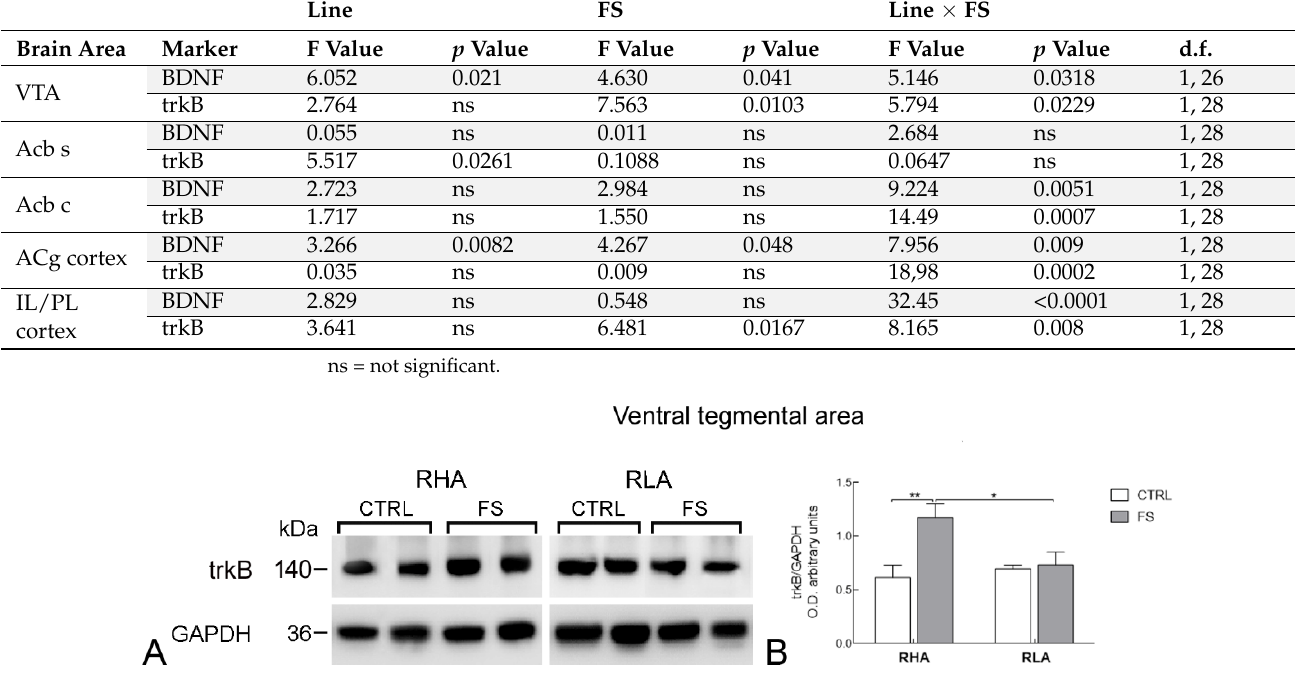
Figure 4. Western blot analysis of the trkB receptor protein levels in the ventral tegmental area of RHA and RLA rats under baseline conditions (CTRL) and after a 15 min session of forced swimming (FS): ( A ) shown are representative samples from two rats; and ( B ) densitometric analysis of the trkB/GAPDH band gray optical density (O.D.) ratios. Columns and bars denote the mean ± S.E.M. of eight rats in each experimental group. *: p < 0.05; **: p < 0.01 (Tukey’s post hoc test or Sidak’s correction for multiple comparisons).